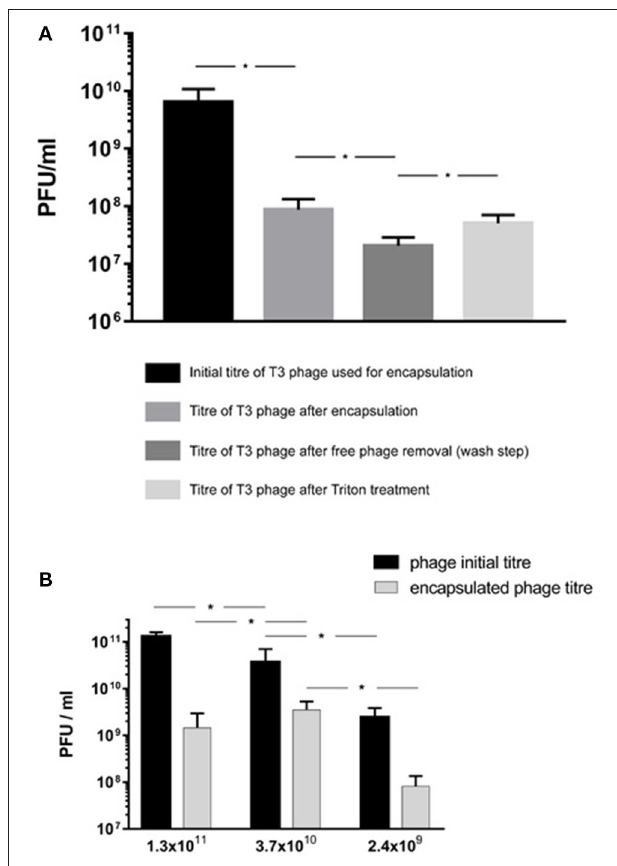
FIGURE 6 | E. coli T3 phage encapsulation in DSPC:cholesterol liposomes. T3 phages were encapsulated at FRR of 2:1 at room temperature. Free phages were separated by centrifugation for 10min at 13,000 × g and re-suspended in SM buffer, the process was repeated three times to remove unencapsulated phages. Liposomes were disrupted with Triton X-100 and phage titer assessed by plaque assay. (A) Phage T3 titers following encapsulation, after removal of unencapsulated free phages (following three wash steps) and after liposome disruption with Triton X-100. (B) Phage encapsulation yield using different initial phage titers and after encapsulation, free phage removal by centrifugation (as above) and then liposome disruption with Triton X-100. *Indicates significance ( p < 0.05) using 2-sample t -test.